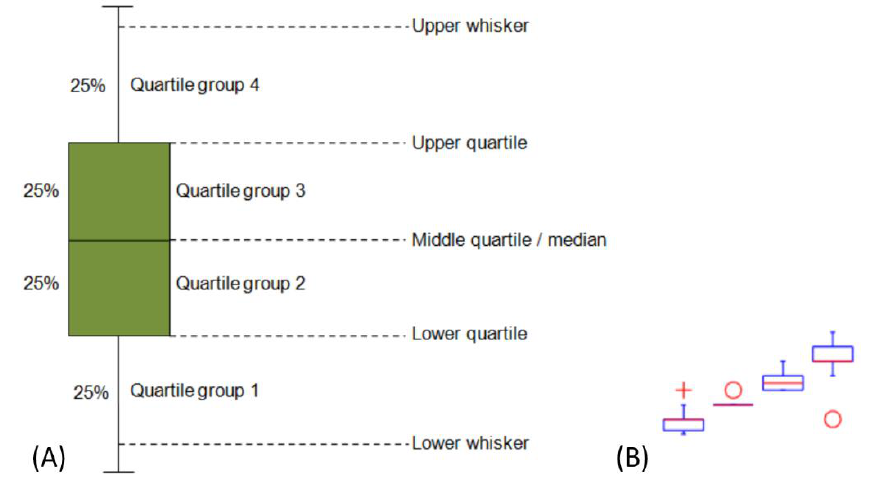
Figure 8. ( A ): Quantile of measured values [36]. ( B ): Symbols displaying values outside the basic range.